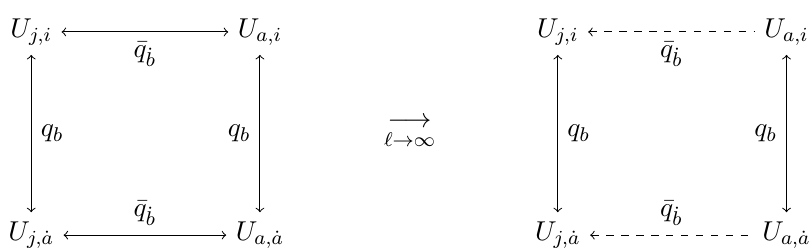
Figure 1 . On the left we have the SO(8) degrees of freedom of the massive vertex (3.26). On the right side, after taking the limit ‘ ! 1 , we are left with two partially independent massless multiplets, connected only by the algebra